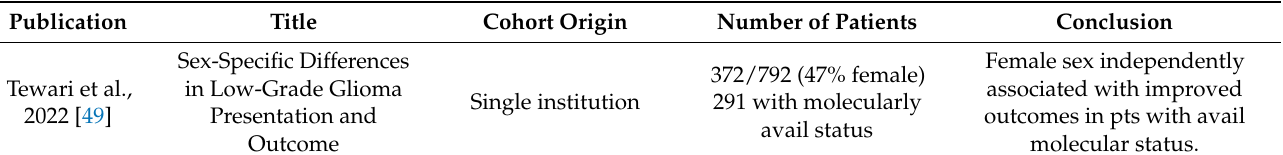
Table 3. Studies aimed at sex-specific outcome differences in glioma illustrating the number of patients included in the study with % female inclusion and generated